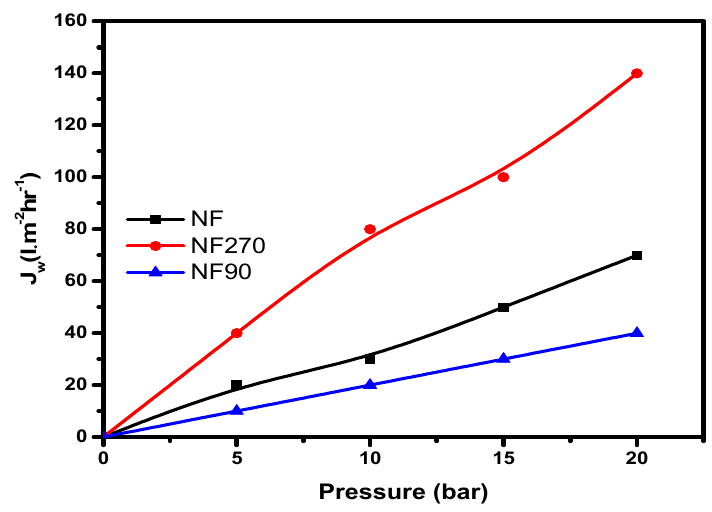
Figure 4. Clean water flux on all three membranes (dead-end